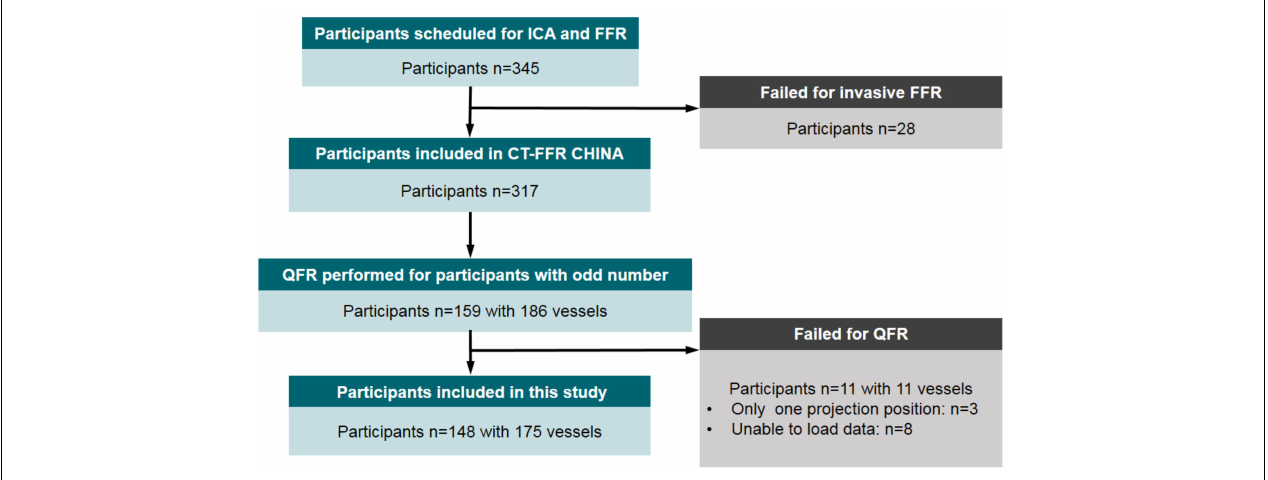
FIGURE 1 | Flow diagram of participant inclusion. ICA, invasive (conventional) coronary angiography; FFR, fractional flow reserve; QFR, quantitative flow